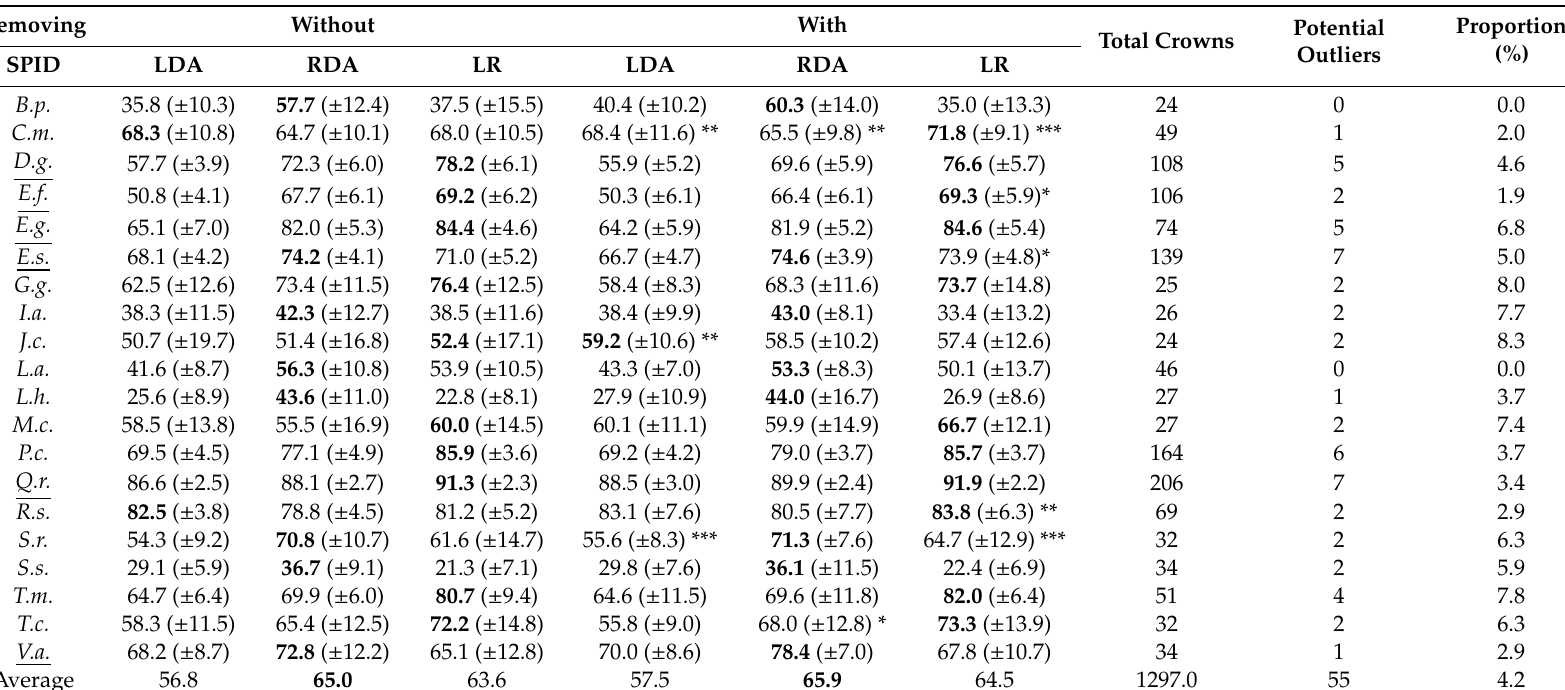
Table A4. Comparison between using all crowns and without some removed crowns based on the Mahalanobis distance. The F-measure is given at object level. Significance codes: * p < 0.1, ** p < 0.05, *** p < 0.01. The best predictions for each species, configuration and method are in bold.